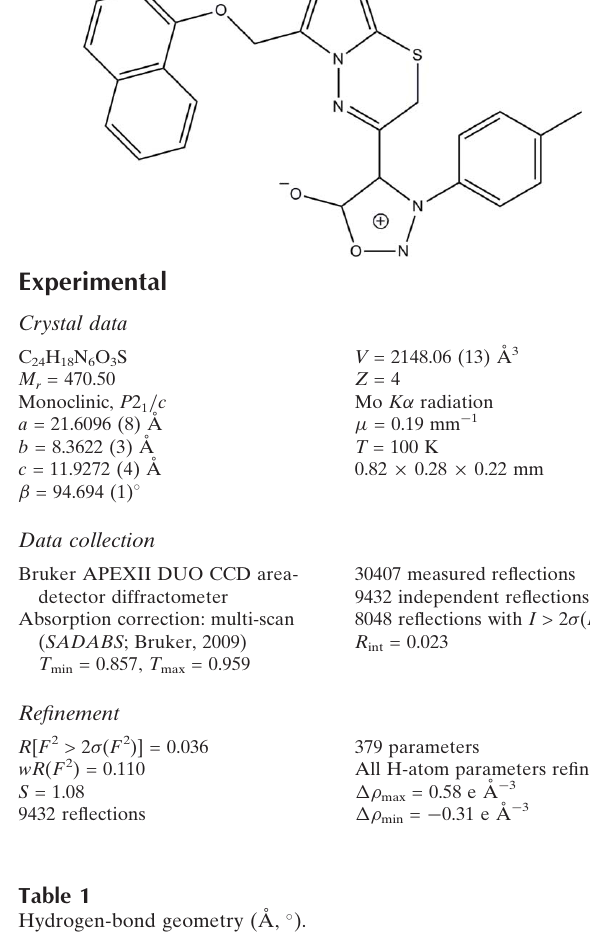
Hydrogen-bond geometry (A˚ , (cid:3)